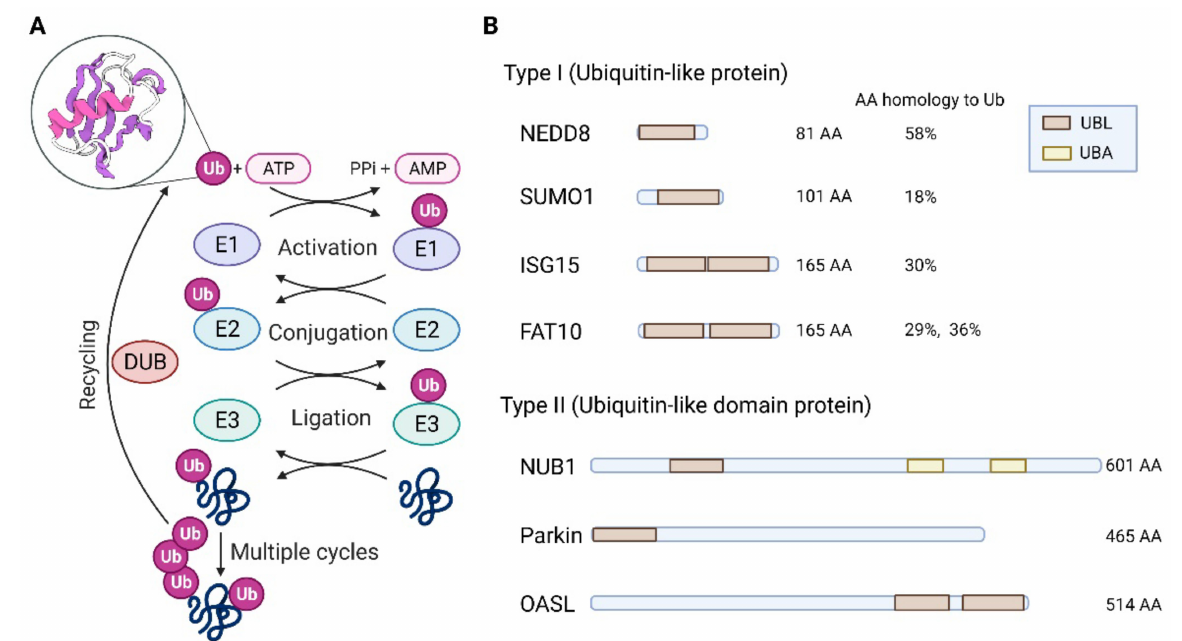
Figure 1. Biochemical and Structural Features of Ubiquitin & Ubiquitin-like Proteins. ( A ) Main steps in the substrate modification process by Ub. The β -grasp globular fold structure of Ub is shown in the circle. ( B ) Examples of structural domains within human type I and type II Ub family members. DUB, de-ubiquitinating enzymes; FAT10, HLA-F-adjacent transcript 10; ISG15, Interferon-stimulated gene 15; NEDD8, Neural precursor cell-expressed developmentally down-regulated gene 8; NUB1, NEDD8 ultimate buster 1; OASL, 2 (cid:48) -5 (cid:48) -oligoadenylate synthetase-like protein; SUMO1, small ubiquitin-like modifier 1; Ub, ubiquitin; UBL, ubiquitin-like domain; UBA, ubiquitin-associated domain. Figure 1A adapted from “ubiquitination”, by BioRender.com (accessed on 1 March 2022). Retrieved from https://app.biorender.com/biorender-templates. Agreement number is